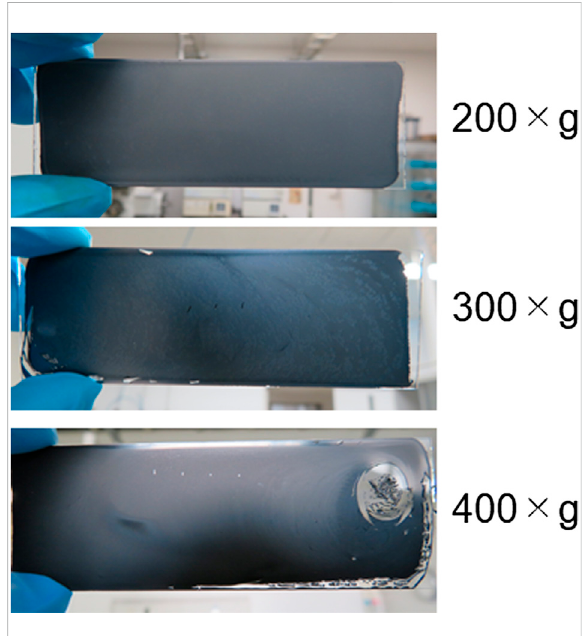
FIGURE 3 Photographs of typical coated LAG fi lms on glass